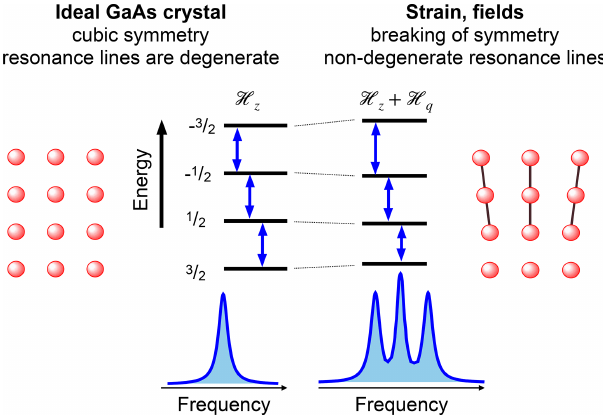
Figure 27. Spectra of I = 3 / 2 spins in ideal and distorted cubic crystals.